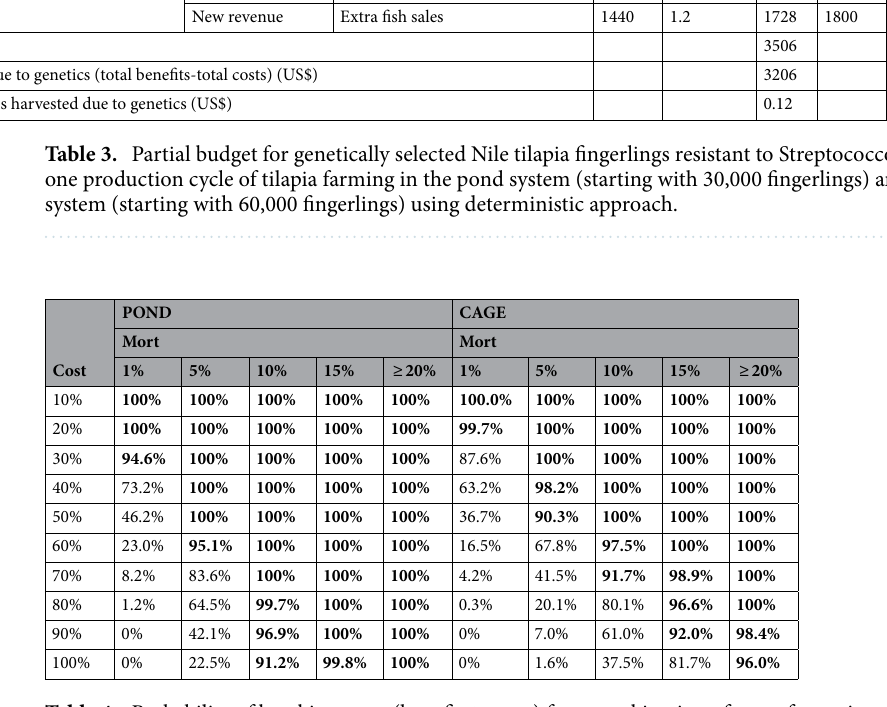
Table 4. Probability of breaking-even (benefits ≥ costs) for a combination of cost of genetics and Streptococcus related mortality, given two production system scenarios. The bold is used to highlight the 90% probability of break-even. “Mort” indicates mortality due to Streptococcosis and “Cost” indicates the extra cost of genetically selected Nile tilapia fingerlings resistant to Streptococcosis over the standard